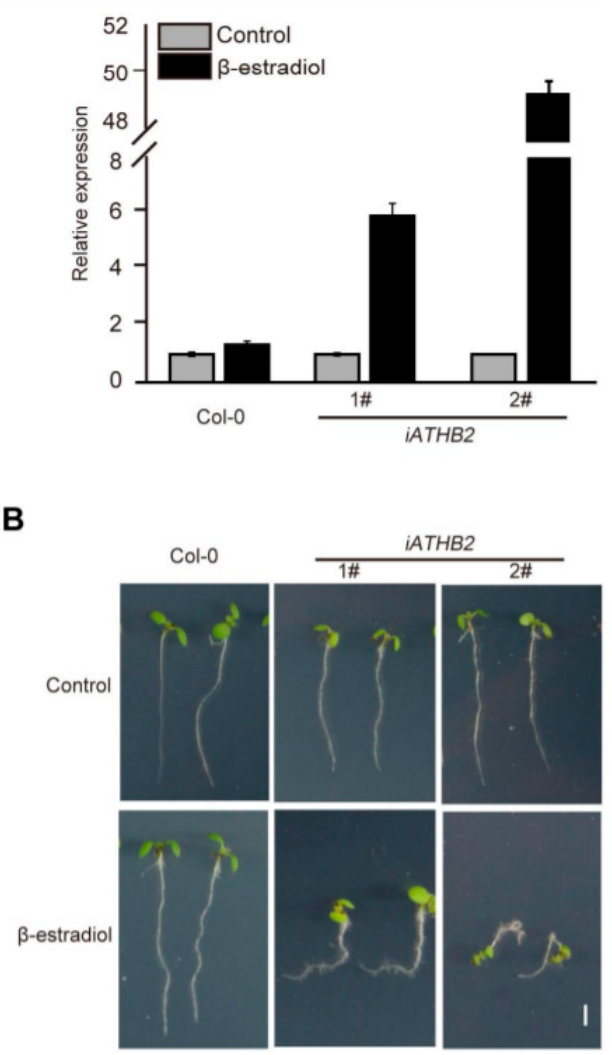
Figure 3. Root gravitropic phenotype of β -estradiol-inducible ATHB2-overexpression transgenic lines. ( A ) qRT-PCR analysis showing the β -estradiol-induced expression pattern of ATHB2 in the iATHB2 lines. The ACTIN gene was used as an internal reference. 1# and 2# represent two independent transgenic lines of iATHB2. The qRT-PCR results were performed for three biological replications and similar results were observed. Representative qRT-PCR results with three technical replicates were shown. Error bars denote ± SD. ( B ) Root gravitropic phenotypes of the iATHB2 transgenic lines. Seedlings of the Col-0 and inducible ATHB2 overexpression plants ( iATHB2 ) were grown on 1/2 MS medium with or without 10 μ M β -estradiol for six days. Two independent transgenic lines were used for phenotypic observation. The images are representative of three independent experiments.